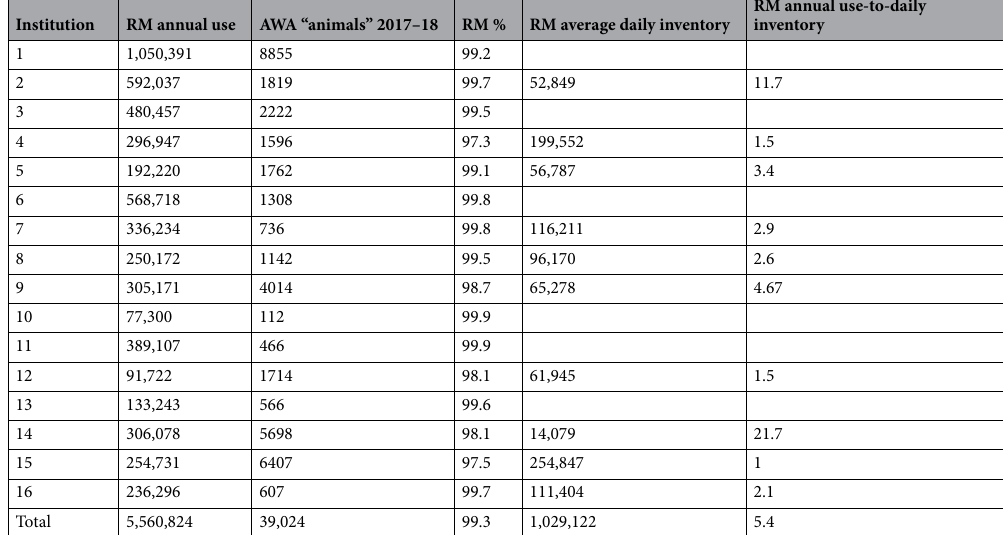
Table 1. Animal numbers from 16 institutions’ annual reports. “RM annual use” the annual reports to AAALAC-International, which institutions shared with the author. “AWA ‘animals’” are publicly available from the United States Department of Agriculture. “RM %” is the percentage of an institutions AWA animals plus annual RM use that is RM. “Rat-Mouse average daily inventory” obtained via Freedom of Information request to the National Institutes of Health Office of Laboratory Animal Welfare; the numbers on those reports do not specify whether it is the number of cages, the counted number of animals, or an estimate of the number of animals based on the standing inventory of